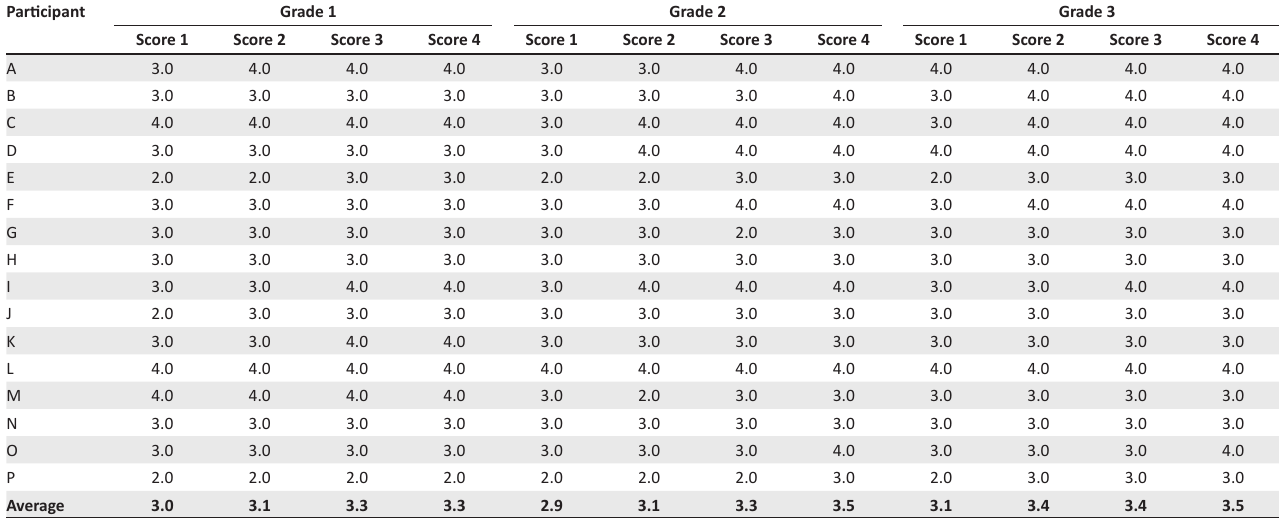
TABLE 3: Reading results of learners in the group that participated in the school’s music instruction programme – The research focus or case study group. Participant